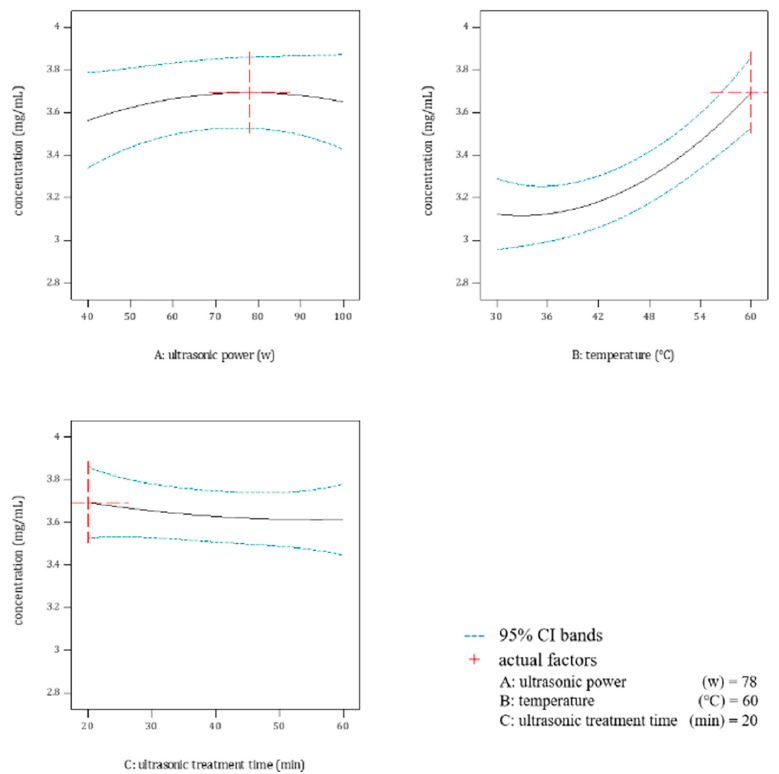
Figure 1. Effects of optimized variables on extracting tea-leaf saponins by Box–Behnken designs. Effects of ultrasonic power, temperature and ultrasonic treatment time on the concentration of tea-leaf saponins in extraction solutions were not similar: quantitative effects of ultrasonic power and temperature belonged to quadratic curves while ultrasonic treatment time’s effect was linear. For